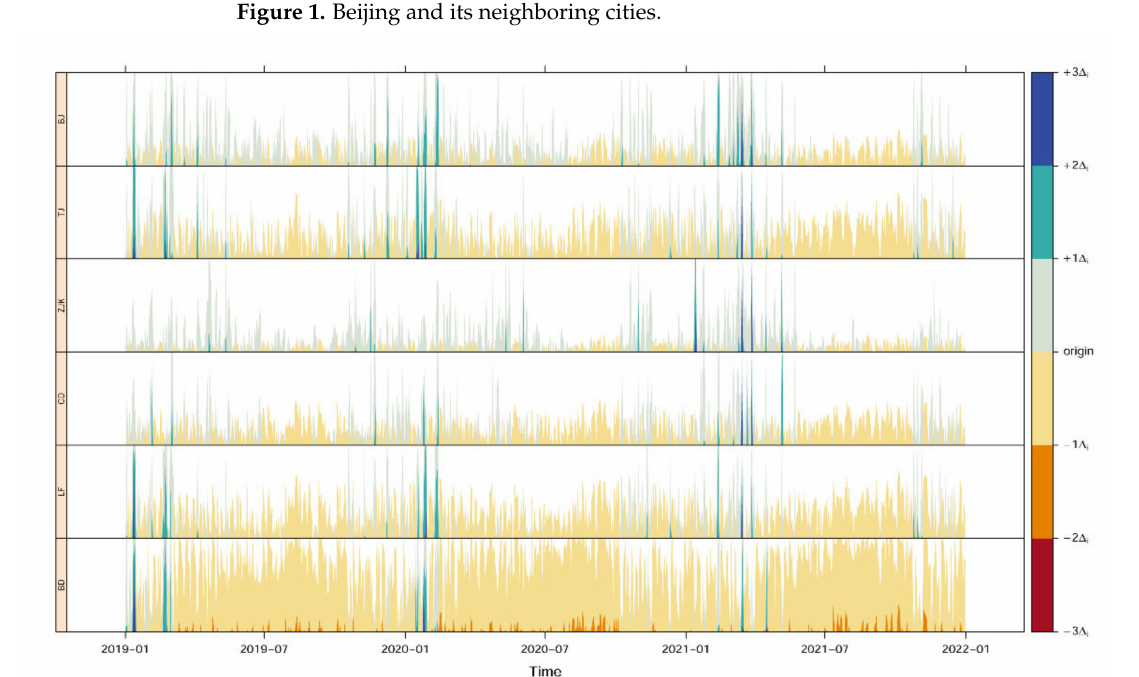
Figure 1. Beijing and its neighboring cities.